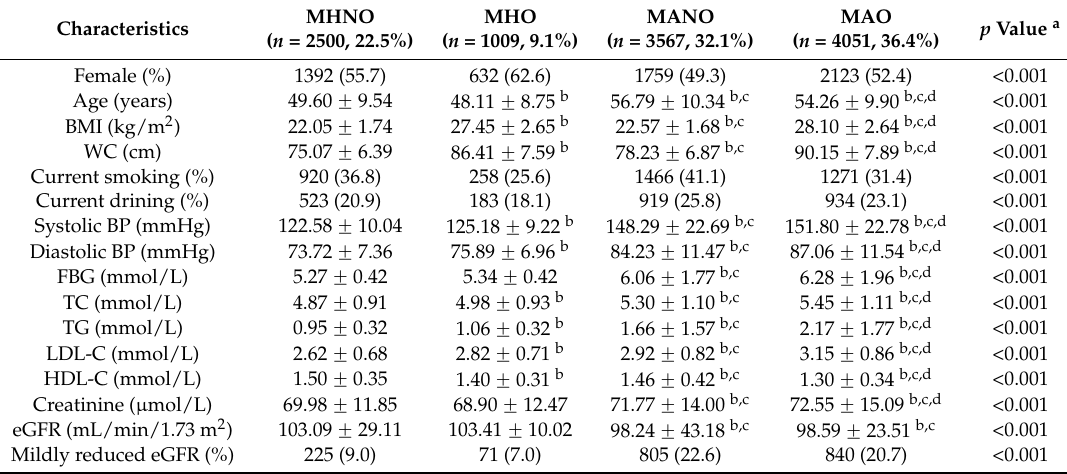
Data are mean ˘ SD or number (%) MHNO metabolically health non-obese, MHO metabolically healthy obese, MANO metabolically abnormal obese, MAO metabolically abnormal obese, BMI body mass index, WC waist circumference, BP blood pressure, FBG fasting blood glucose, TC total cholesterol, TG triglyceride, LDL-C low-density lipoprotein cholesterol, HDL-C high-density lipoprotein cholesterol. eGFR estimated glomerular filtration rate. a Difference between four groups; b p < 0.05 compared with MHNO group; c p < 0.05 compared with MHO group; d p < 0.05 compared with MANO group.